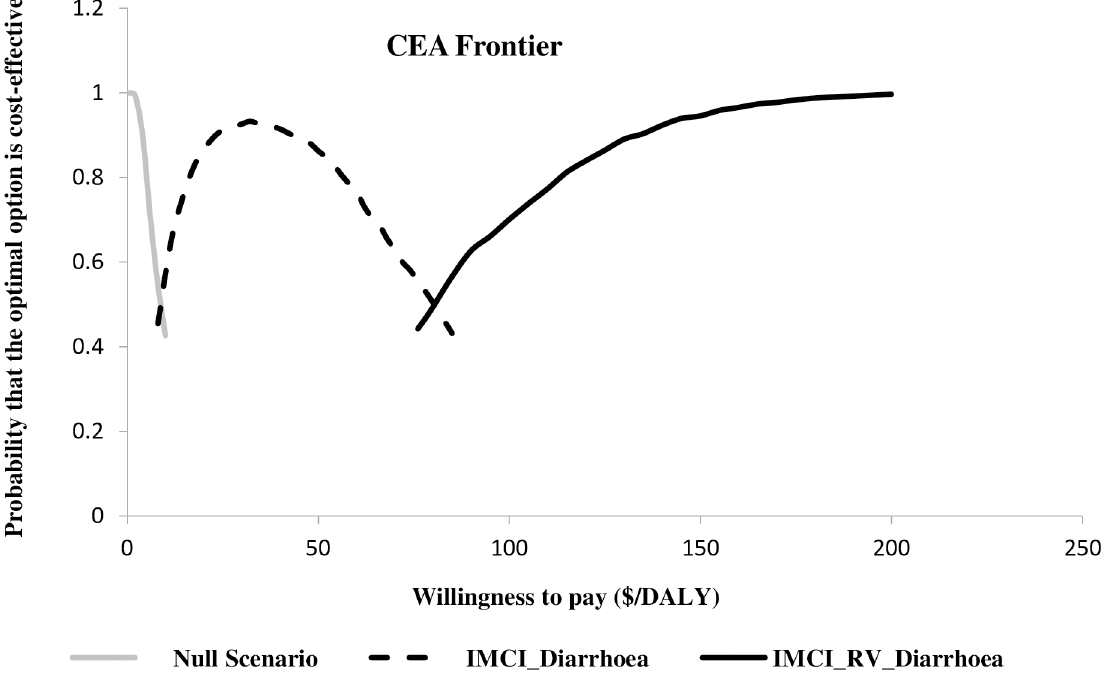
Fig 3. Cost-effectivenessacceptability frontier showing the decision uncertainty surrounding the optimal